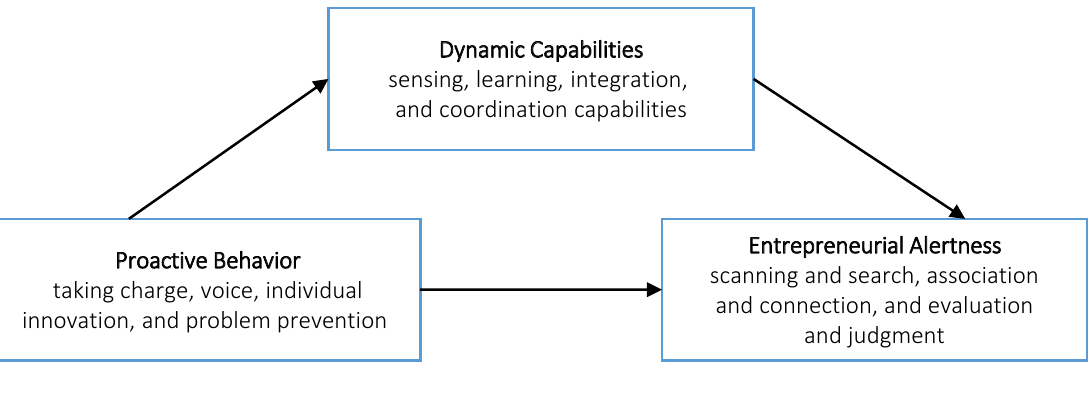
Figure 1. Research Table 1. Demographic profile of respondents Characteristics